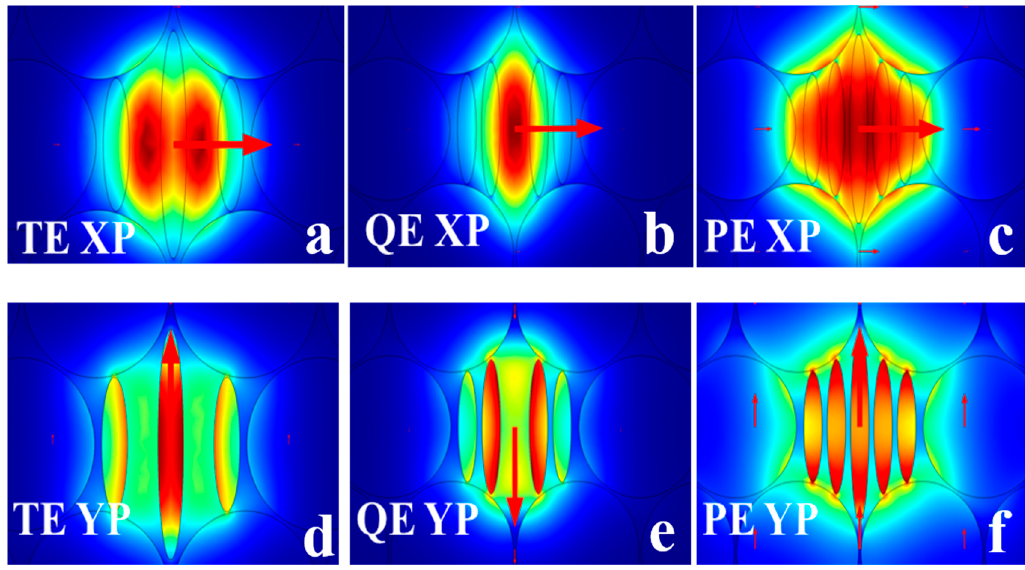
Figure 2. Electric field distribution at 1.2 THz operating frequency of the ( a ) TE X-polarization (XP) mode, ( b ) QE X-polarization mode, ( c ) PE X-polarization mode, ( d ) TE Y-polarization (YP) mode, ( e ) QE Y-polarization mode, and ( f ) PE Y-polarization mode with arrows indicating the direction of the electric field oscillation.